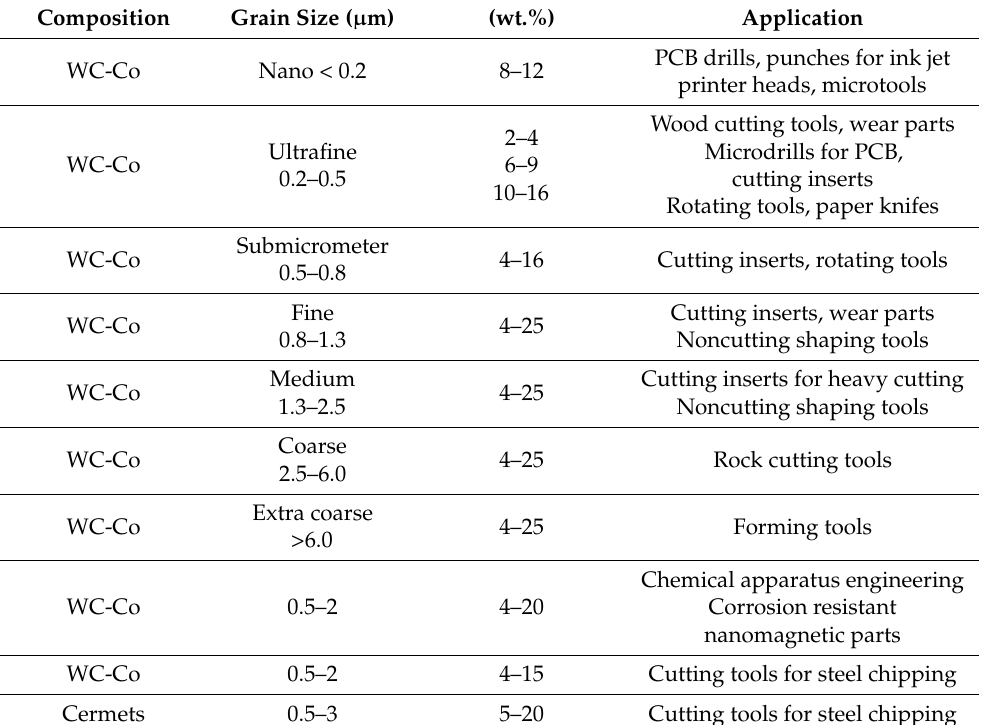
Table 2. Characteristics of hard metal and cermet grades and their application